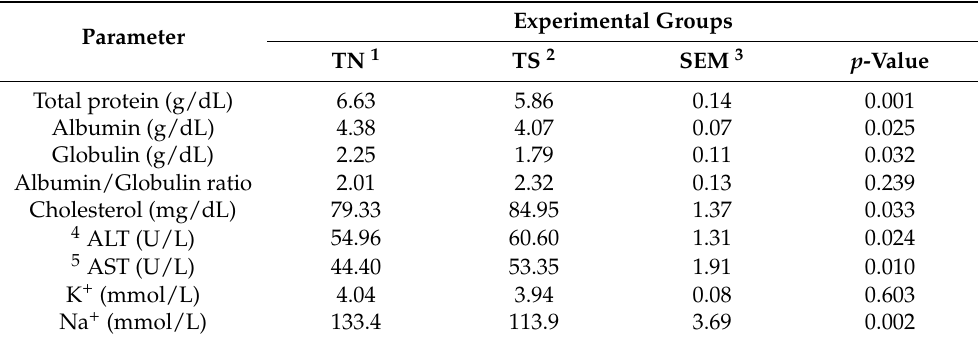
Table 2. Effect of chronic thermal stress on blood chemistry of broiler